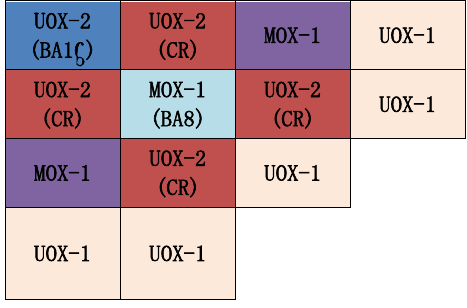
Figure 2. Layout of KAIST 3A Benchmark